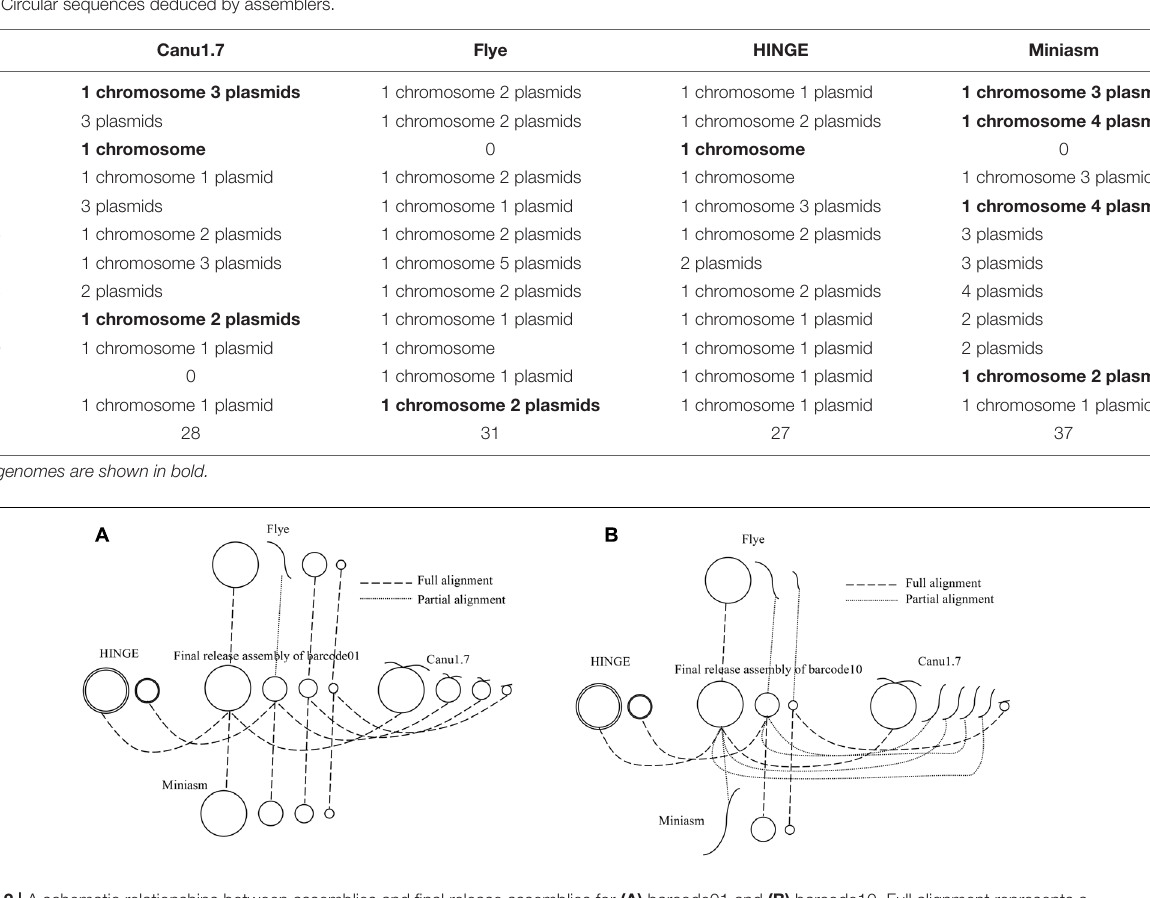
FIGURE 2 | A schematic relationships between assemblies and final release assemblies for (A) barcode01 and (B) barcode10. Full alignment represents a near-perfect correlation between a circular contig and a circular sequence, partial alignment represents a partial correlation between a linear contig and a circular